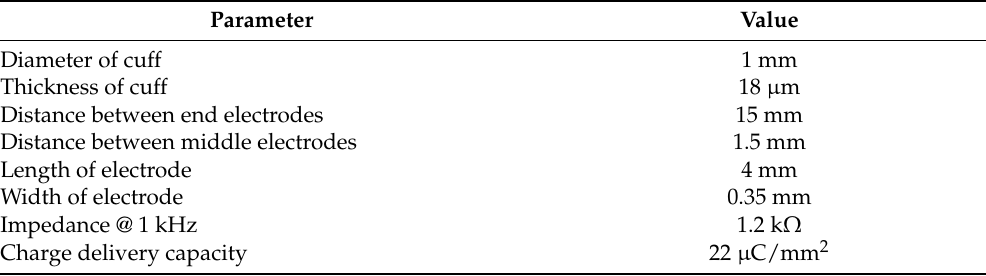
Figure 2. Nerve cuff electrode: ( a ) photographic image and ( b ) schematic image. Table 1. Physical characteristics of the nerve cuff electrode.